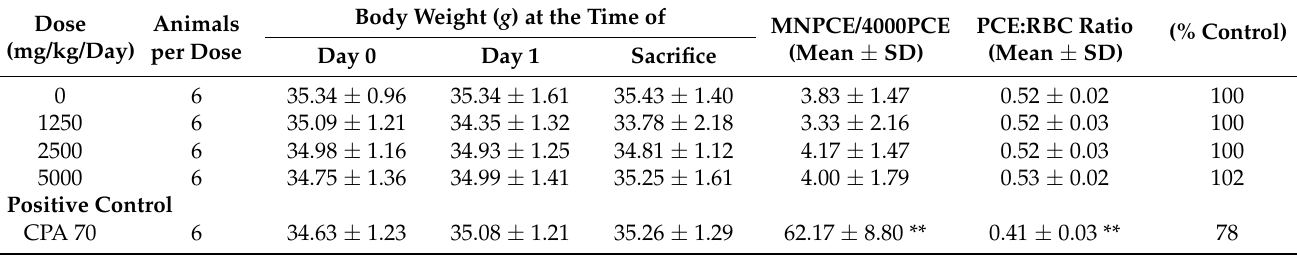
Table 3. In vivo bone marrow micronucleus test of WG